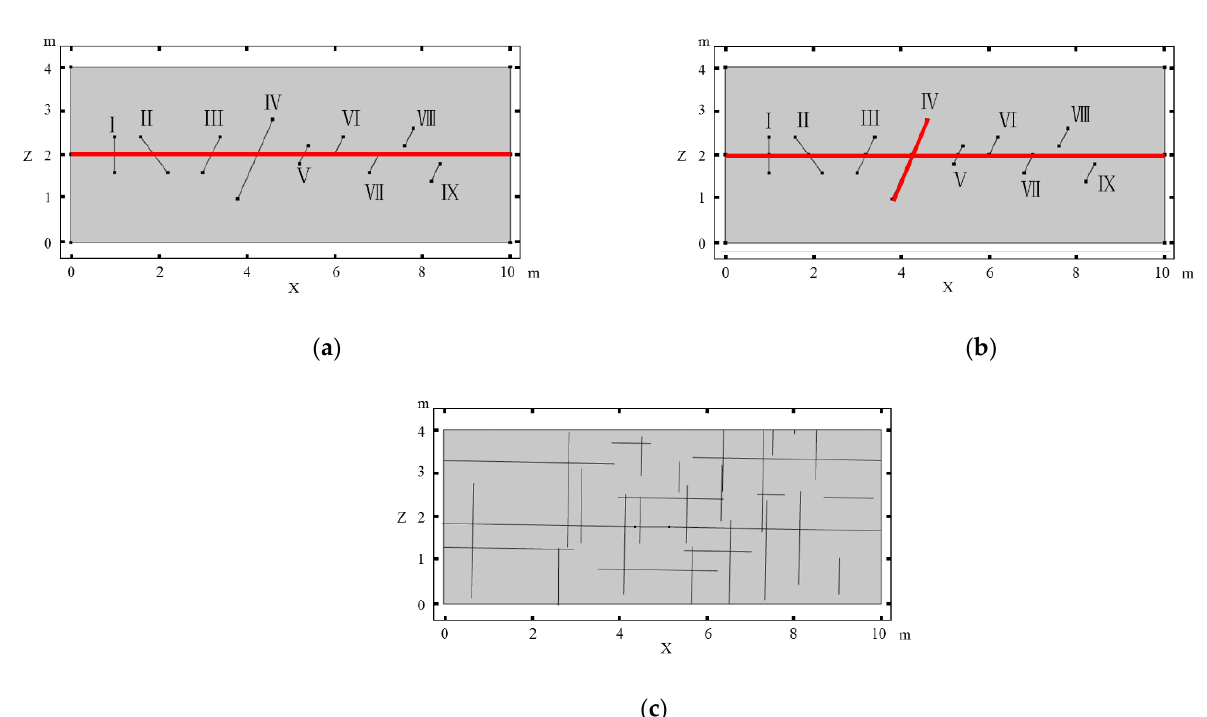
Figure 2. Topology of intersecting fractures used for the numerical models. Red lines indicate fractures with an aperture of 1.1 × 10 −5 m. ( a ) Intersecting fracture set 1 and set 3, ( b ) intersecting fracture set 2, ( c ) fracture network model. Table 1. Parameters of the simulation scenarios.